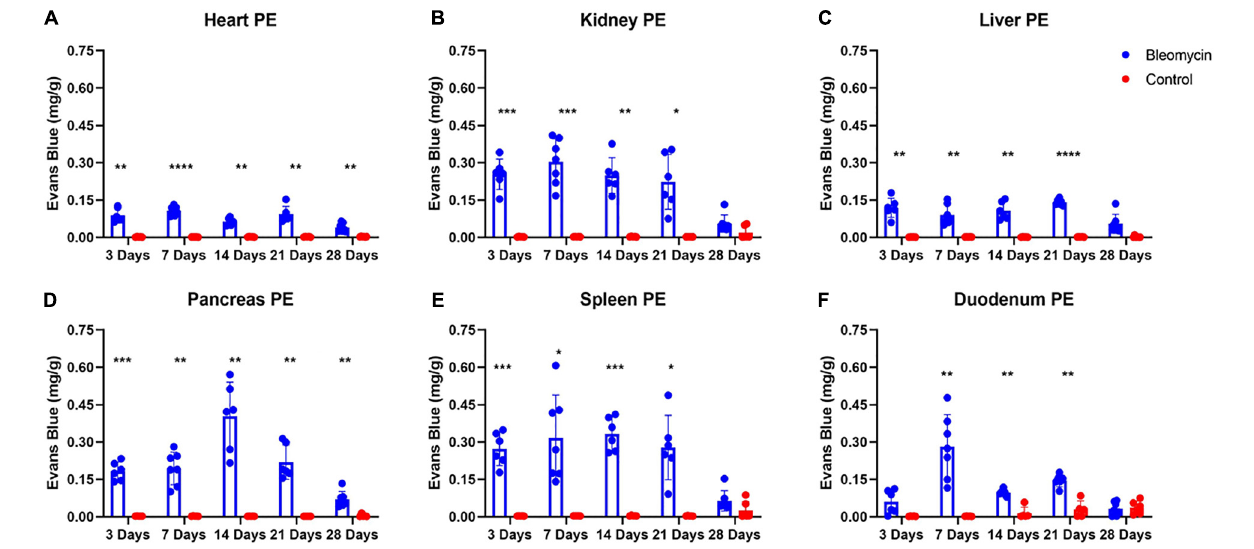
FIGURE 5 | Bleo instillation caused plasma extravasation starting at day 3 for all organs except the duodenum (A–F) . Resolution of plasma extravasation occurred after day 21 for all organs except the heart and pancreas (A–F) . Mean ± SD. n = 5–7 per group. Comparing bleomycin with control group * P < 0.05, ** P < 0.005, *** P < 0.0005, **** P <